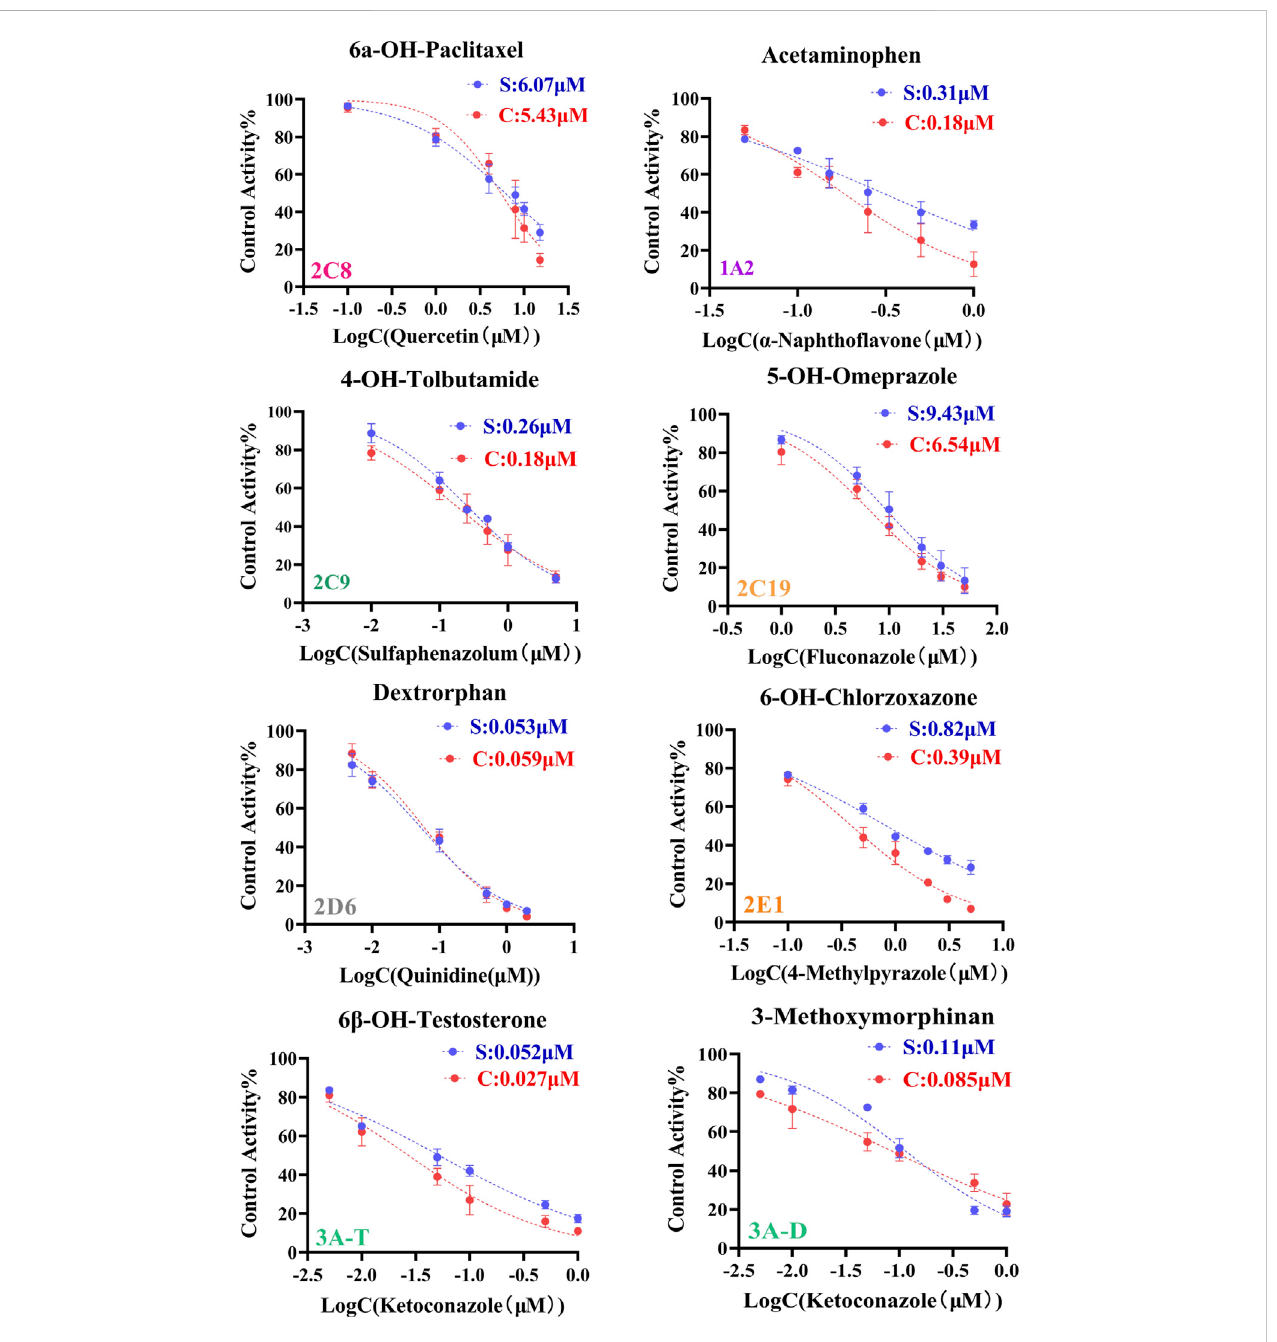
FIGURE 2 Inhibition curves each substrate incubated with cocktail assay and single substrate method. Note: 3A-T, CYP3A (Testosterone); 3A-D, CYP3A (Dextromethorphan).